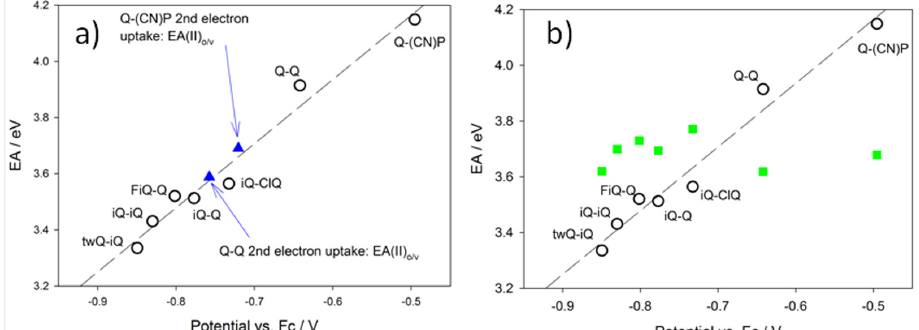
Figure 9. ( a ) Calculated electron affinity (EA) vs. Experimental Reduction Potential. Black circles: vertical electron affinity vs. experimental reduction potential (EA(I) vert vs. E 2 ). Blue solid triangles: Q-Q and Q-(CN)P compounds only, which show the relevant EA(II) o⁄v vs. E 1 (Table 1). ( b ) Calculated EA vs. Experimental Reduction Potential. Black circles: vertical electron affinity vs. experimental reduction potential (EA(I) vert vs. E 2 ). Green squares: EA(II) o ⁄ v vs. E 2 data .